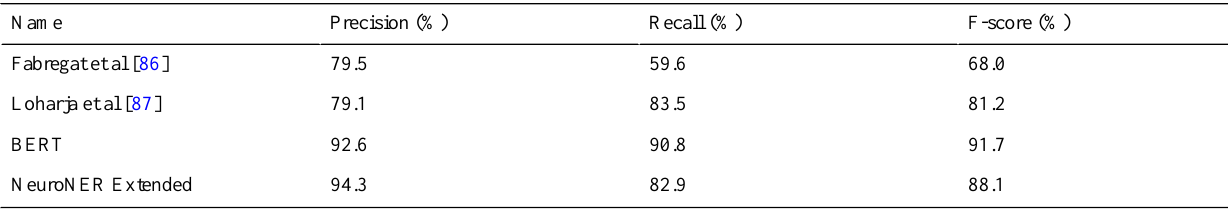
Table 23. Results of negation cues and scope detection for the SFU ReviewSP-NEG data set.